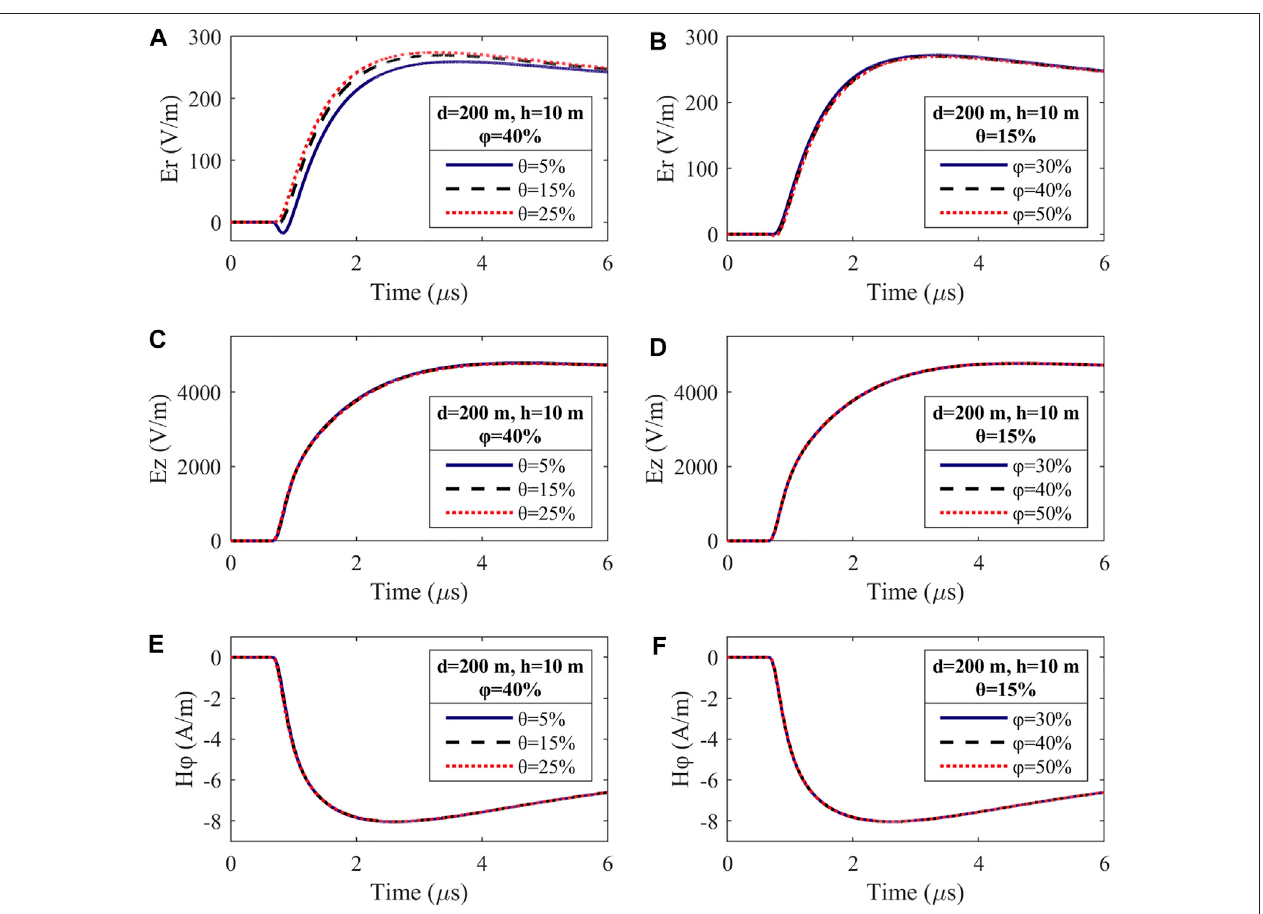
FIGURE 4 | FDTD-computed subsequent return stroke waveforms of the (A,B) horizontal electric fi eld (Er), (C,D) vertical electric fi eld (Ez), and (E,F) azimuthal magnetic fi eld (H φ ) (d (cid:2) 200m, h (cid:2) 10m). (A,C,E) Different water contents θ (cid:2) 5%, 15%, and 25% when the porosity φ (cid:2) 40%. (B,D,F) Different porosities φ (cid:2) 30%, 40%, and 50% when the water content θ (cid:2)